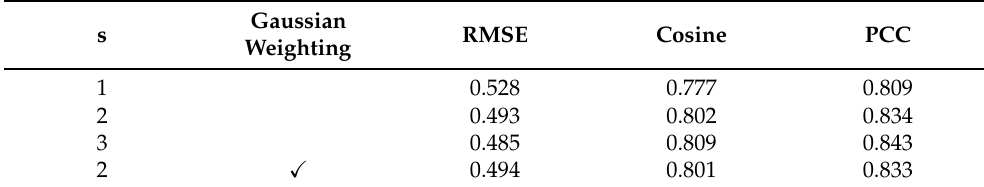
Differences in metrics when evaluating full EVC images. CTX